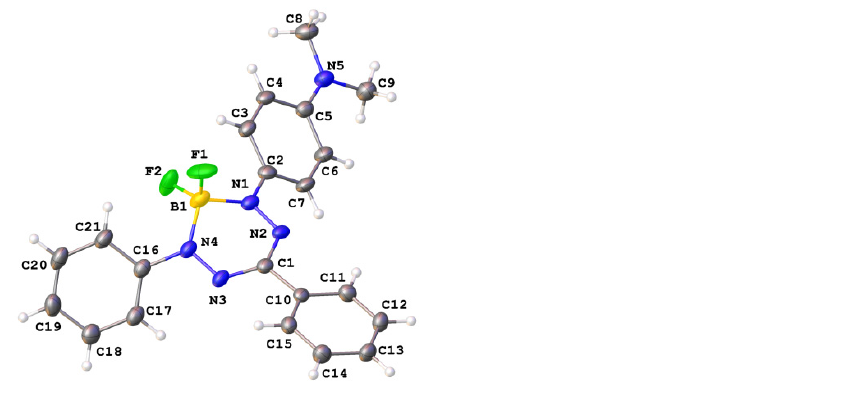
Figure 3. Crystal structure of compound 18 with labeling schemes and 50% thermal ellipsoids.